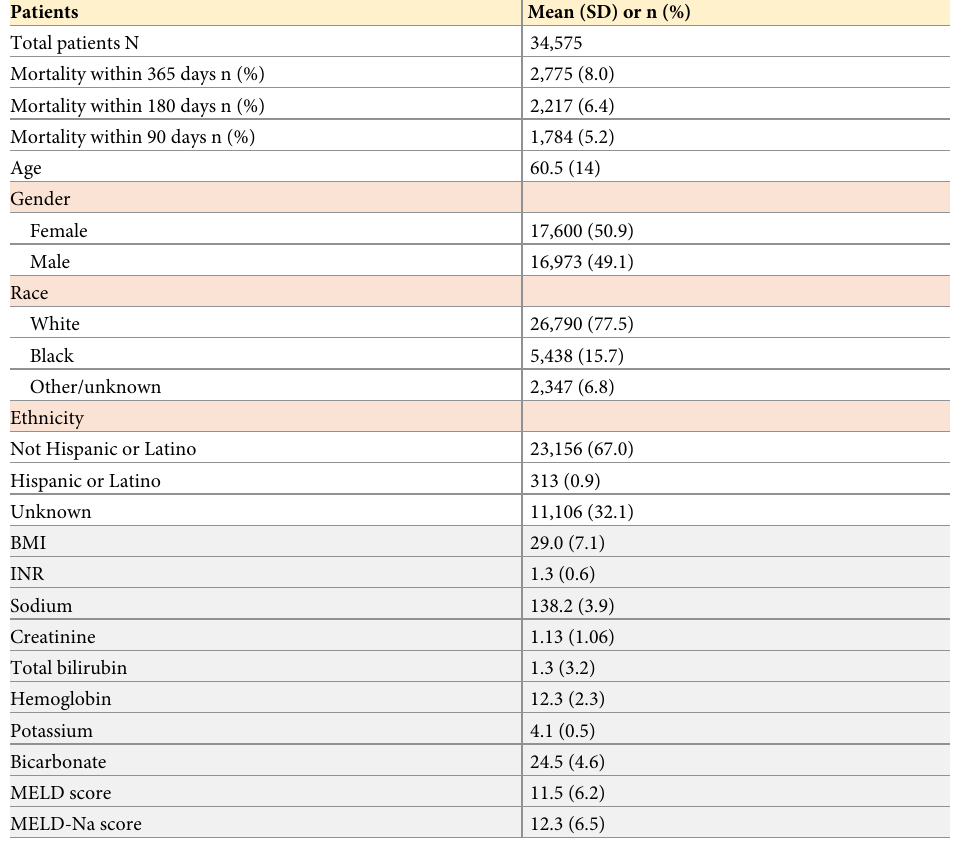
Table 1. Characteristics [mean (SD) or n (%)] of our study